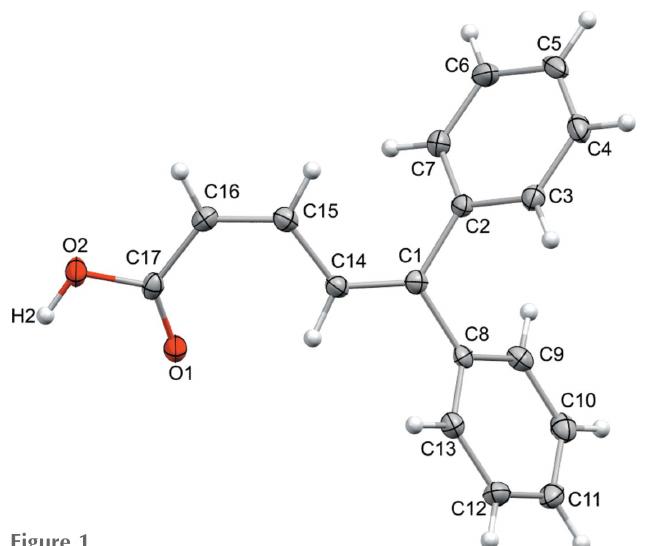
Figure 1 The title molecule with 50% probability ellipsoids.